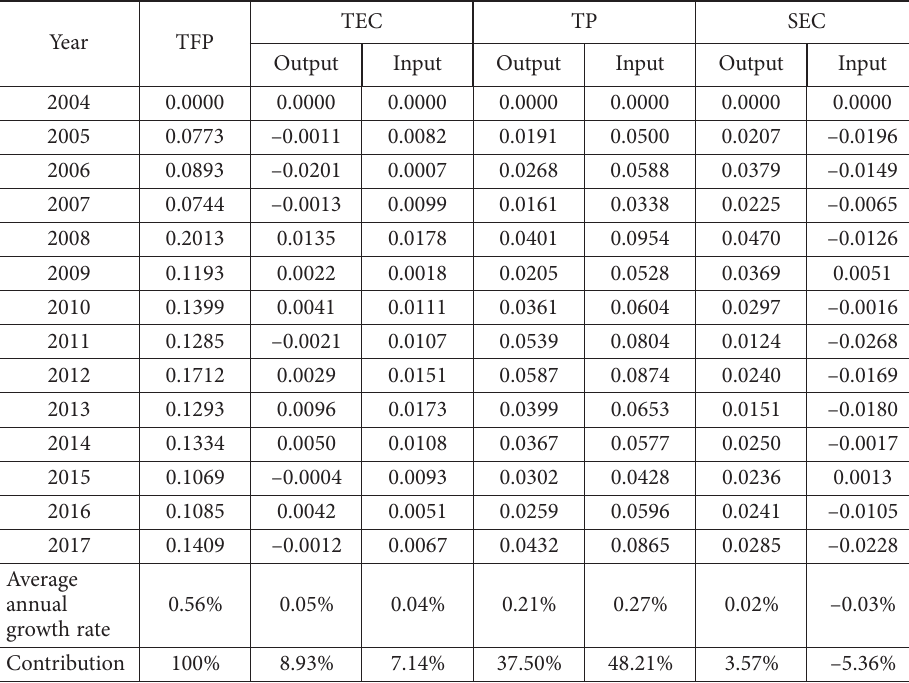
Table 2. Annual average national growth rates of the TFP indicator and its decomposition